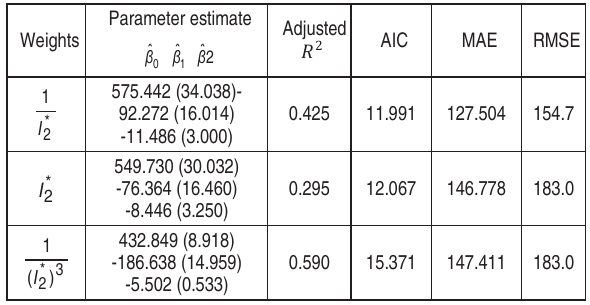
Table 6. Parameter estimates for weighted regression model (standard errors in